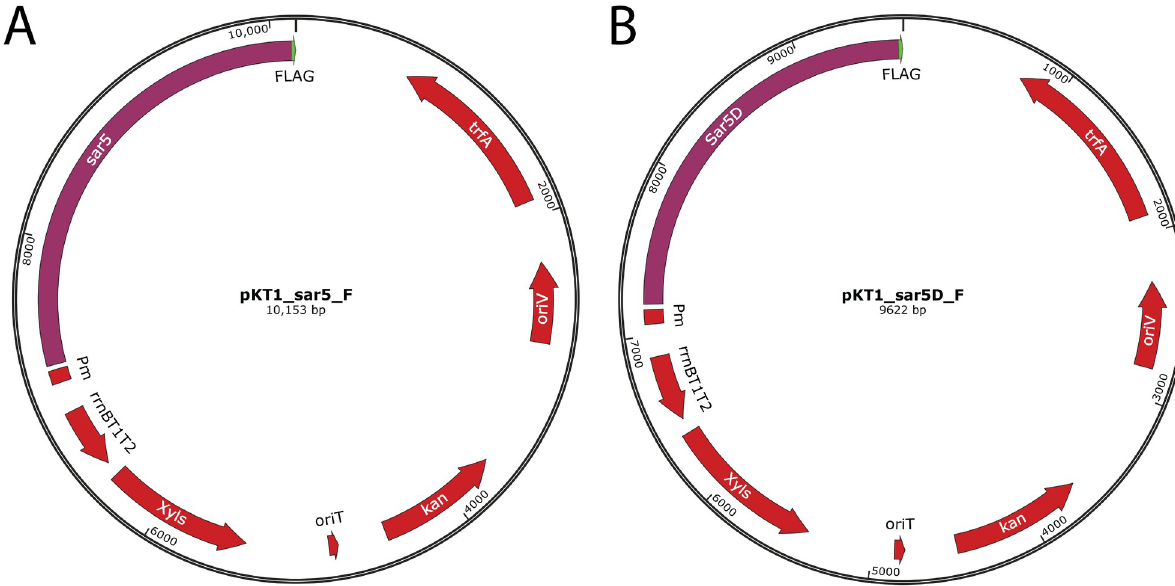
Fig 3. To induce expression of sar5, the luciferase reporter gene of pKT1 [31] was replaced by FLAG-tagged sar5 and FLAG-tagged sar5D, creating (A) pKT1-sar5-F and (B) pKT1-sar5D-F, respectively. xylS, gene encoding the transcription activator XylS. Pm, promoter at which XylS binds and activates transcription in response to the inducer m-toluate. kanR, gene encoding resistance to kanamycin. oriV, origin of replication for RK2-derived plasmids. trfA, gene encoding plasmid replication initiator protein TrfA, activating replication by binding to oriV. rrnBT1T2, transcriptional terminator. oriT, origin of conjugal transfer. The plasmid maps were generated using SnapGene software (from Insightful Science).